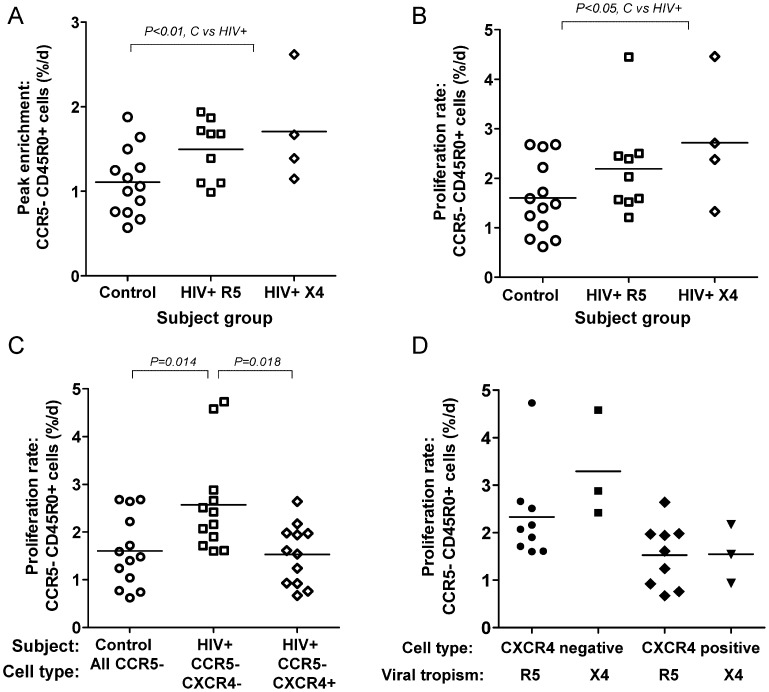
HIV infection increases turnover rates of CCR5-negative CD4+CD45R0+ memory T-cells.HIV infection and turnover rates of CCR5− memory T-cells, expressed either as peak enrichment (A) or modeled proliferation rate (B) for all CD4+CD45R0+ CCR5− cells, according to subject group: HIV+ R5, HIV-positive subjects with R5-tropic virus; HIV+ X4, HIV-positive subjects with X4-tropic virus. When CCR5− cells in HIV+ subjects were subdivided by CXCR4 expression (C), the effect of HIV infection was found to be confined to the CXCR4− compartment; x-axis separated by subject group and cell type; control samples were not subdivided by CXCR4 expression. (D) Relationship between proliferation rates, CXCR4 expression and viral tropism in CD4+CD45R0+ CCR5− cells in HIV+ subjects.